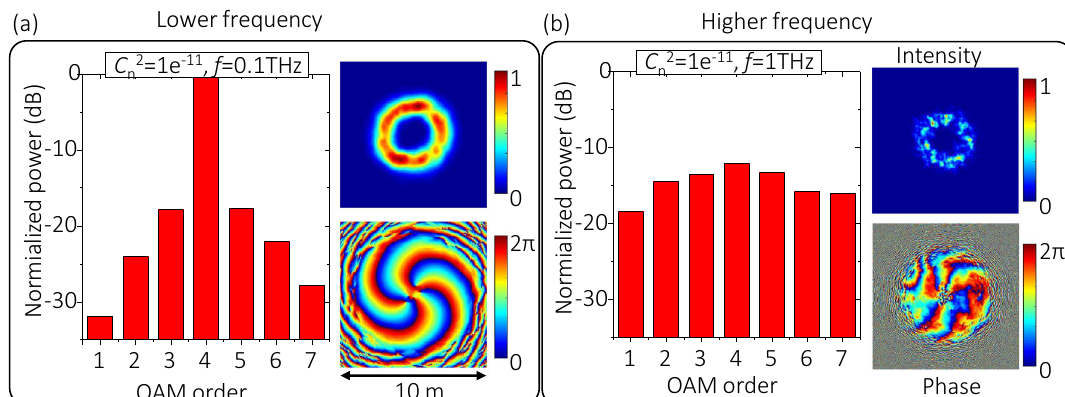
2 n = 1 × 10 –11 m −2/3 , f = 0.1 THz, and